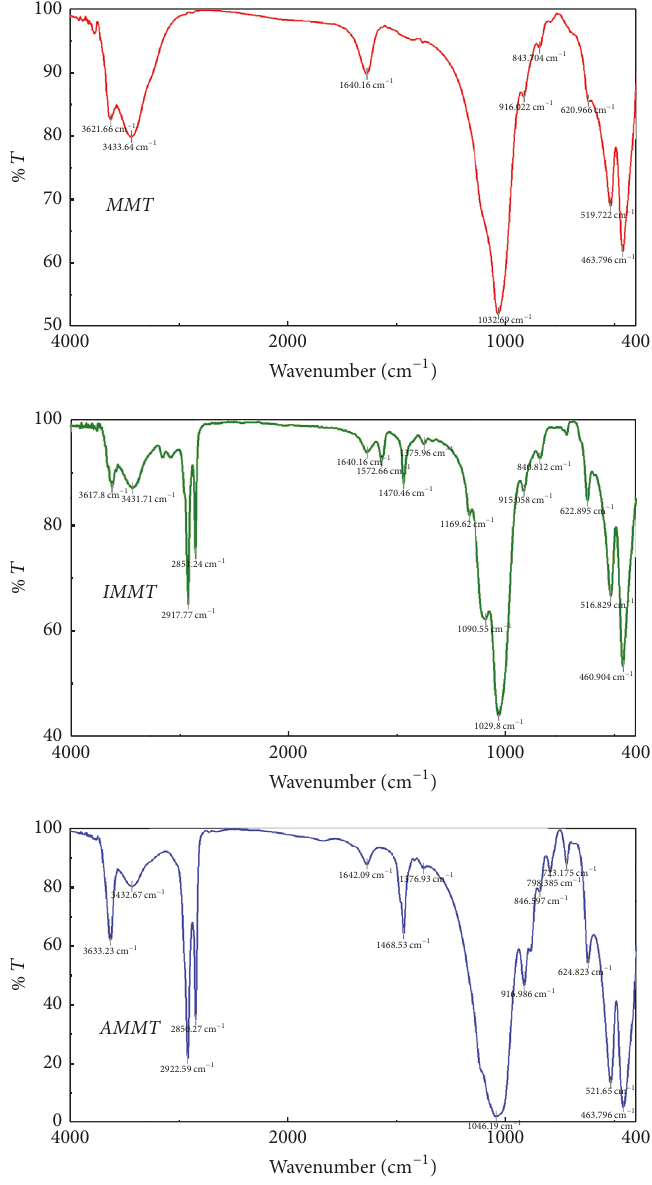
Figure 1: FTIR Spectra of MMT, IMMT, and